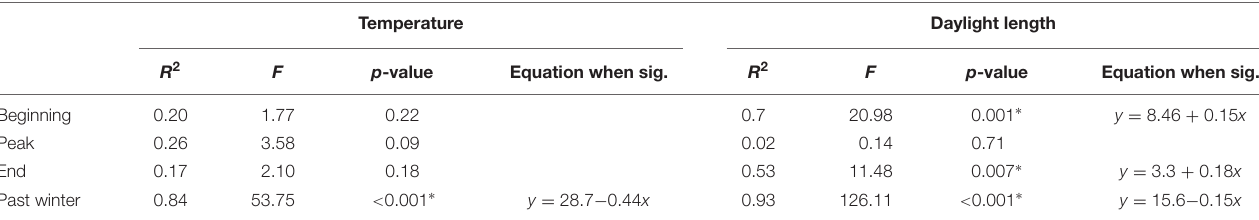
TABLE 2 | Results from the linear regressions between latitude and temperature (water for beginning, peak, and end; air for past winter) or daylight length at the different stages of the growing season (beginning, peak, and end) and for the past winter. Temperature Daylight length R 2 F p -value Equation when sig. R 2 F p